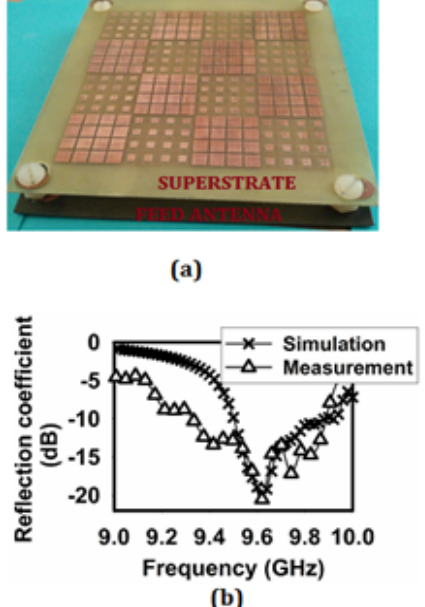
Figure.6.Simulated response from top surface of free